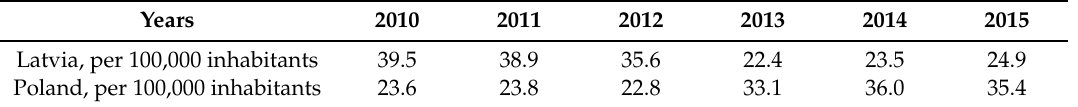
Table 1. Number of Borreliosis cases, per 100,000 inhabitants in Latvia and